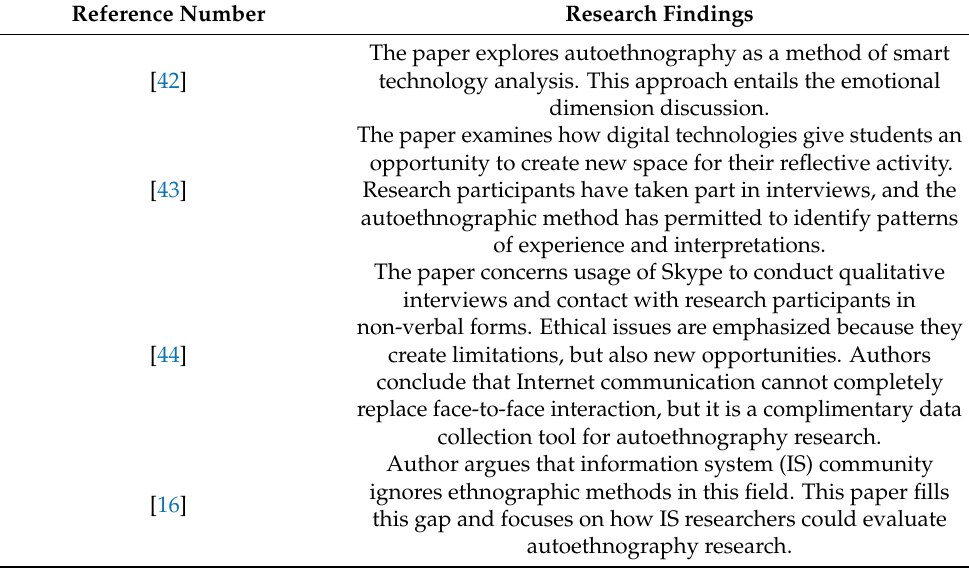
Table 4. Autoethnography research publications on ICT solutions